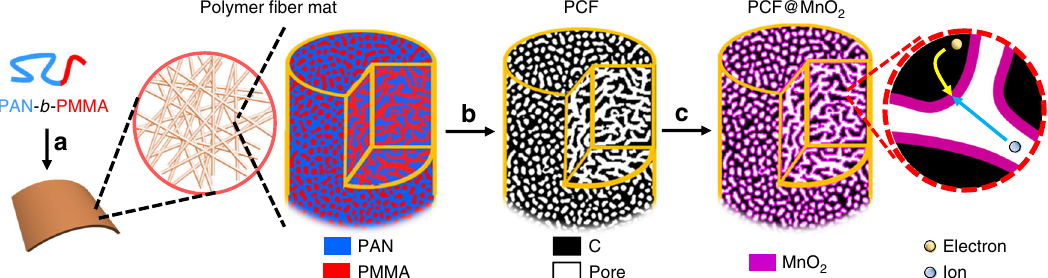
Fig. 1 Schematic illustration of the synthesis of PCF and PCF@MnO 2 . a PAN- b -PMMA block copolymer is spun into a polymer fi ber mat. (Magni fi ed view) PAN (blue) and PMMA (red) in the block copolymer fi bers microphase separate into a bicontinuous network structure. Via thermal oxidation, PAN is crosslinked to ensure a high yield of conductive carbon network. b Upon pyrolysis, the polymer fi bers are converted to porous carbon fi bers (PCFs, black) with continuous and uniform mesopores (white channels), which afford high loadings of transition metal oxides. c The PCFs are loaded with MnO 2 (magenta) to become PCF@MnO 2 through a solution-based redox deposition reaction. (Magni fi ed view) The continuous carbon fi ber matrix and the partially fi lled mesoporous channels provide effective expressways for electron conduction and ion diffusion,